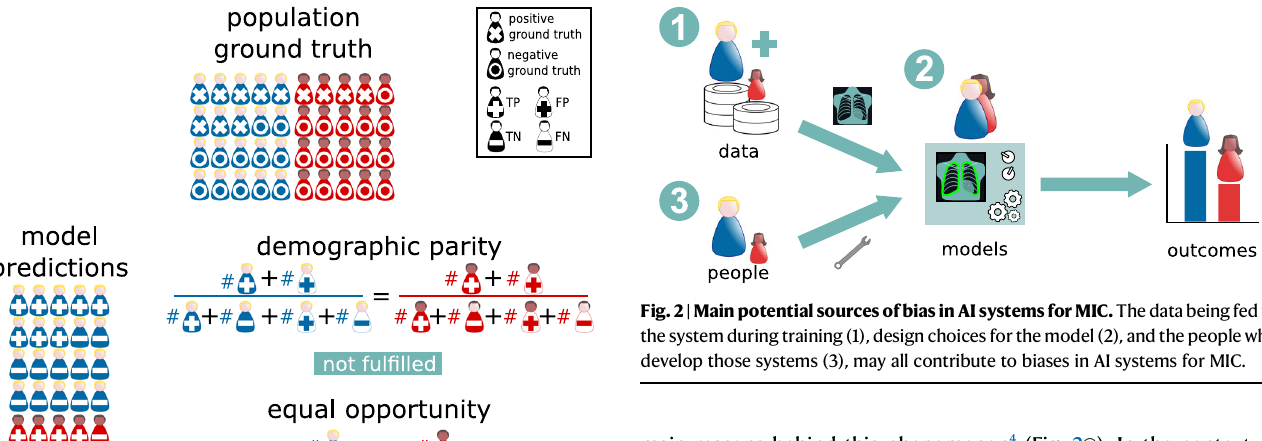
algorithm is unfair for presenting a higher probability of a positive